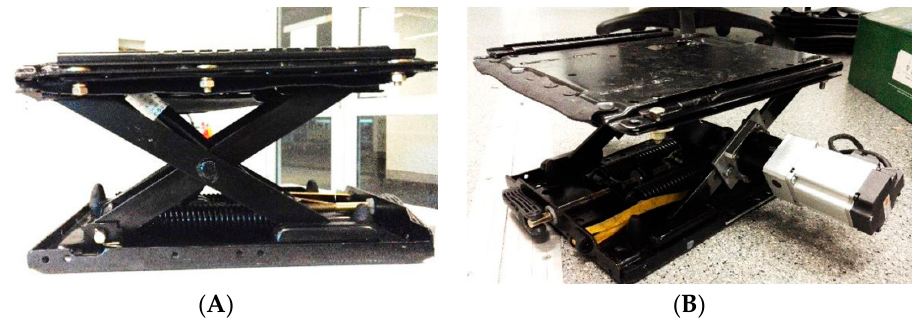
Figure 1. Prototype of passive seat suspension ( A ) and active seat suspension ( B ) [22].